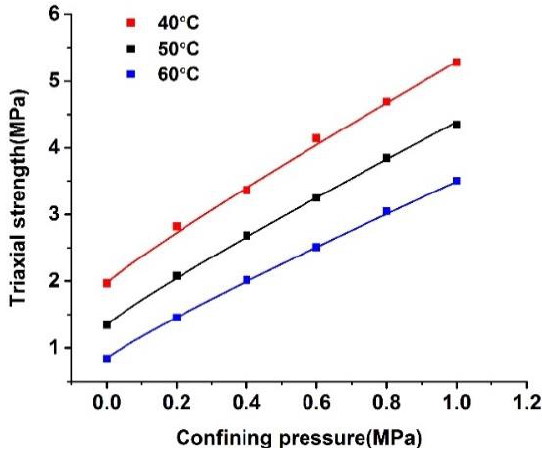
Figure 5. Triaxial results of SMA-13 asphalt mixture.